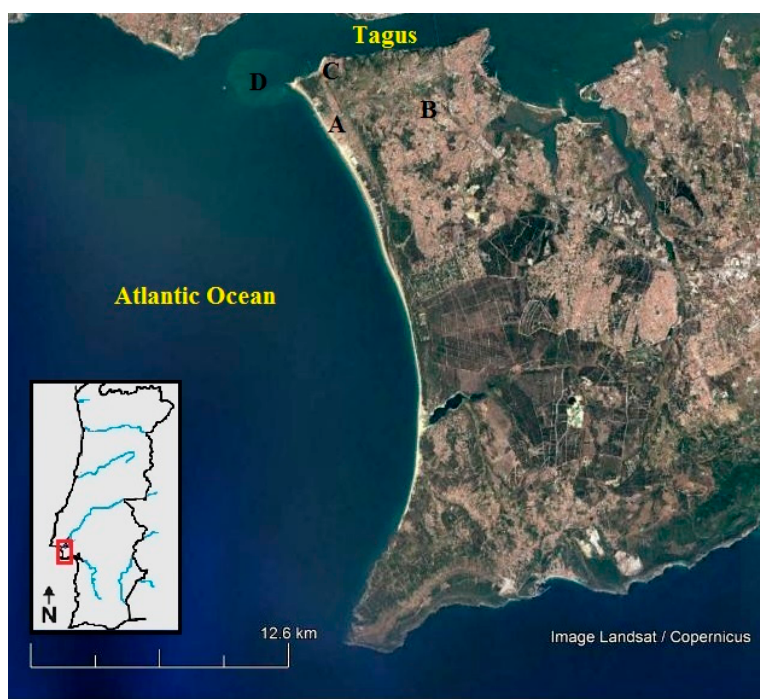
Figure 1. Study area. A) Costa da Caparica; B) Sobreda; C) Trafaria; D) Tagus mouth.